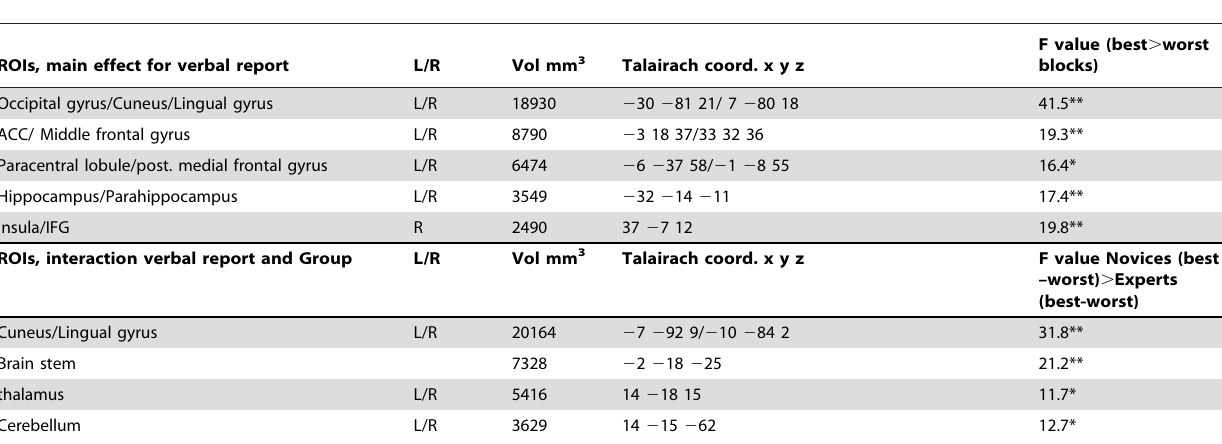
Table 2. Activation during poor vs. good blocks of meditation, as verbally reported.